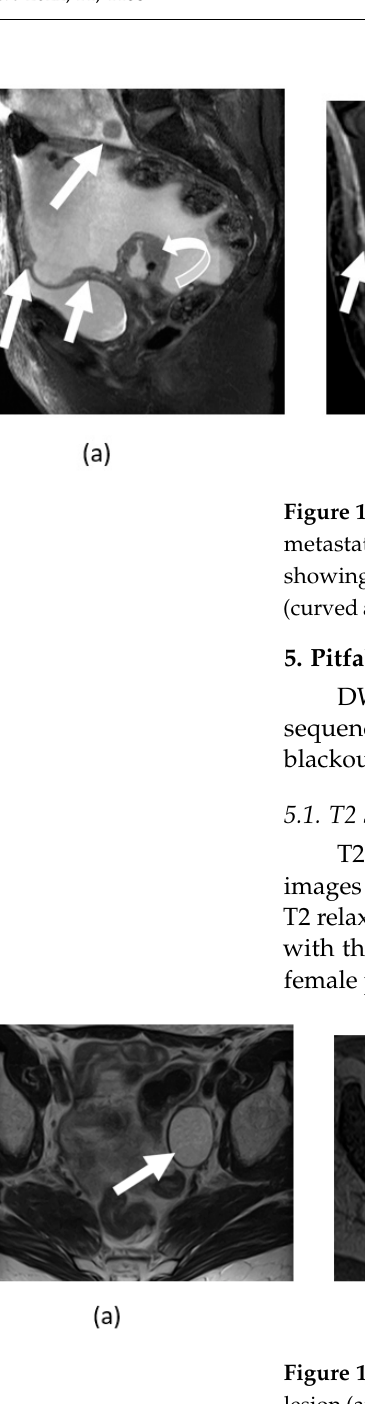
Figure 17. Axial T2-weighted image ( a ) and sagittal contrast-enhanced CT image ( b ) show posterior pelvic lobulated solid mass (arrows) from biopsy serous ovarian tumor with diffusion restriction on corresponding DWI ( c ) and ADC maps ( d ).